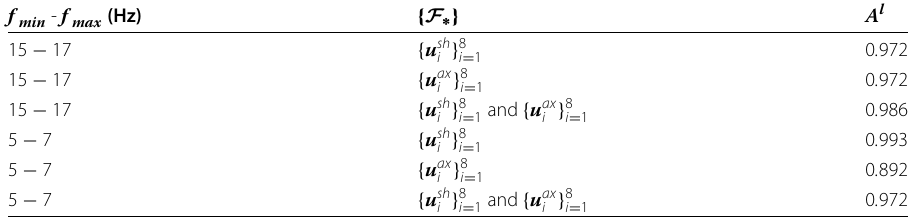
Table 6 Damage localization, case